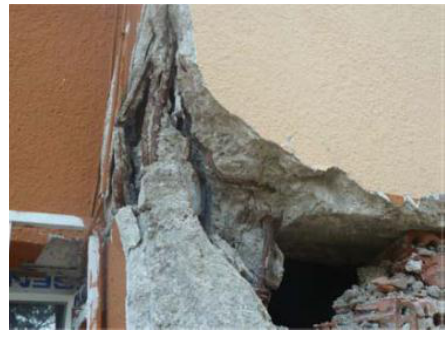
Figure 14. Poor reinforcement detailing at a column end